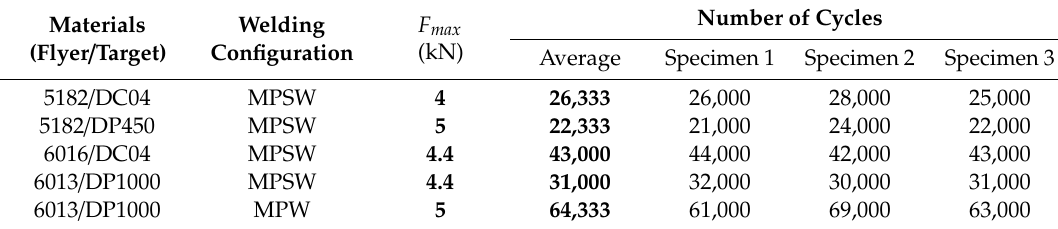
Table 13. Fatigue tests results (R = 0; f = 20